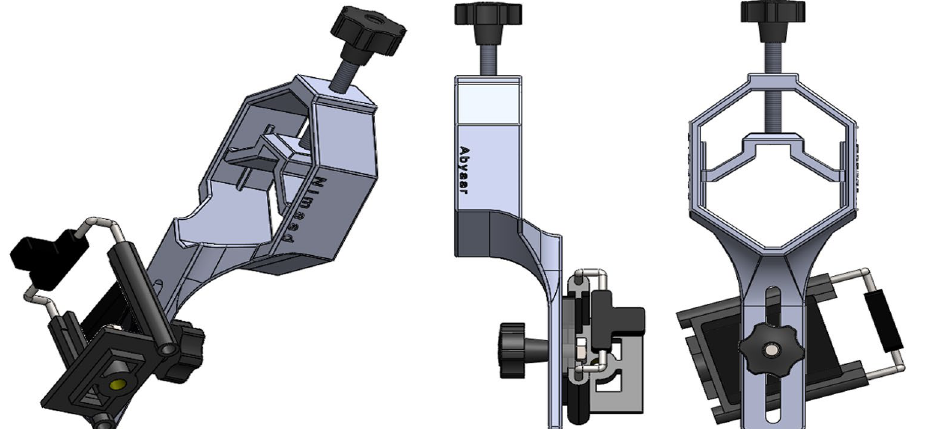
Figure 4. Designed adapter to mount smart phones on the ocular lens of a microscope to make the act of capturing the photos from the samples quicker and easier. Experts work with a microscope manually and see the images on the mounted smartphone and take